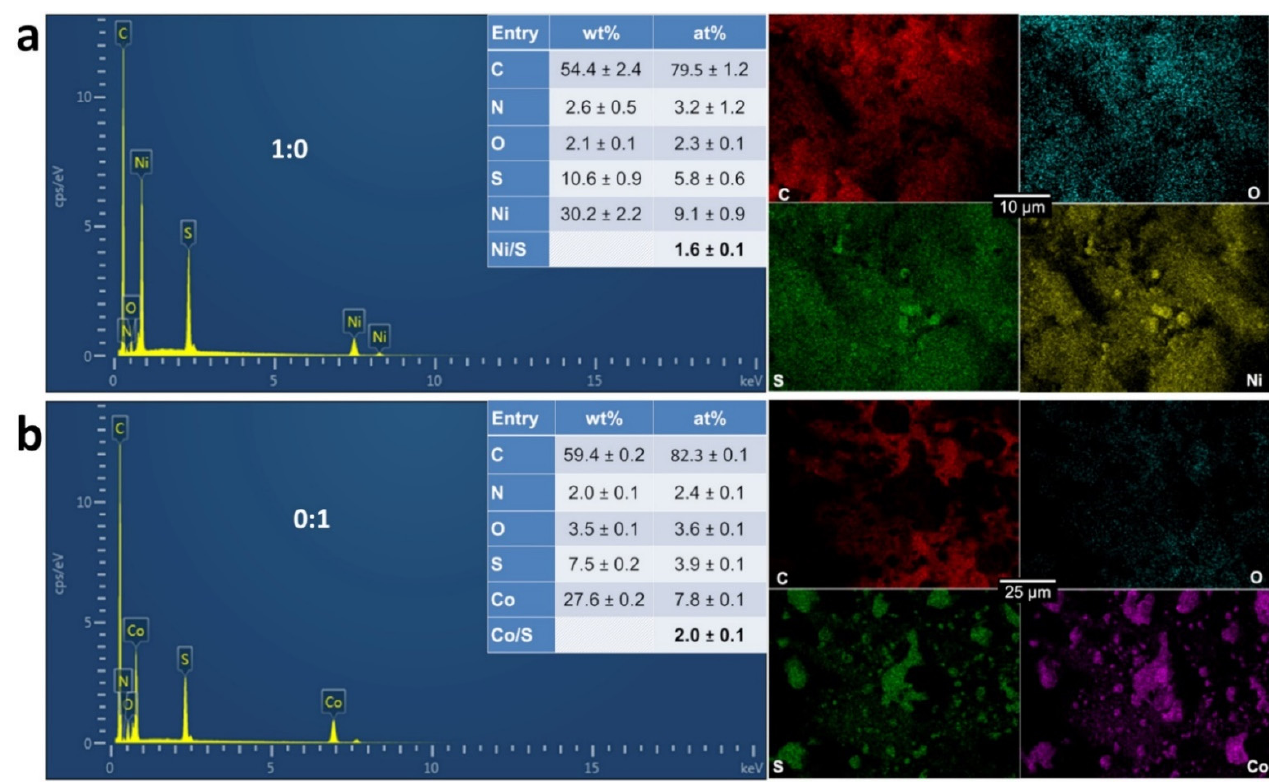
Figure 4. EDX spectra and the corresponding EDX maps of the as-synthesized monometallic electrocatalysts for PANI- Ni:PANI-Co ratios of: 1:0 ( a ), and 0:1 ( b ) based on atomic ratio of Ni:Co after calcination.